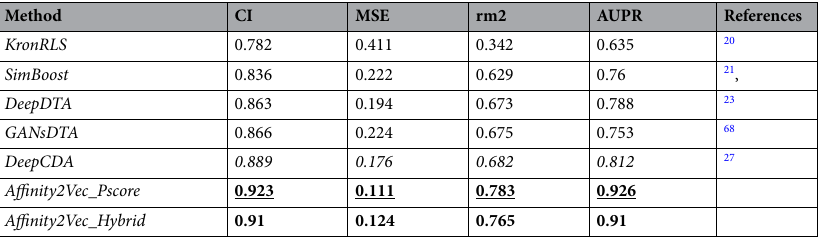
Table 5. Comparing Affinity2Vec with five baseline methods in terms of CI, MSE, rm 2 , and AUPR scores for the KIBA dataset on the test data. Bold font with underline indicates the best results, bold font alone shows the second-best results, and italic font shows the third-best results.